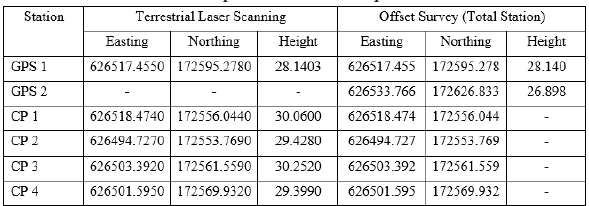
Table 3.2 Result of GPS points and checkpoints